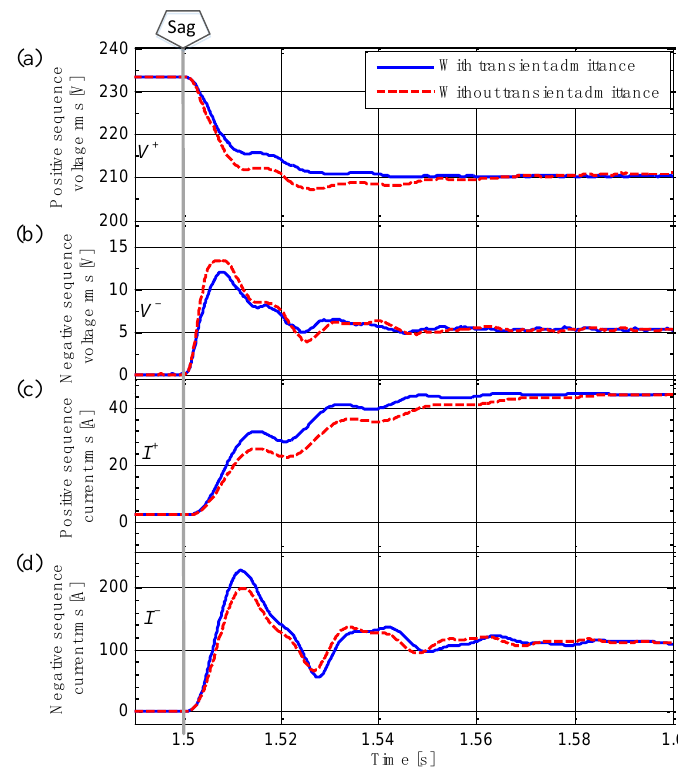
Figure 9. Effect of the transient admittance branch under an asymmetrical grid fault: ( a ) positive sequence PCC voltage rms; ( b ) negative sequence PCC voltage rms; ( c ) positive sequence current rms; and ( d ) negative sequence current rms.